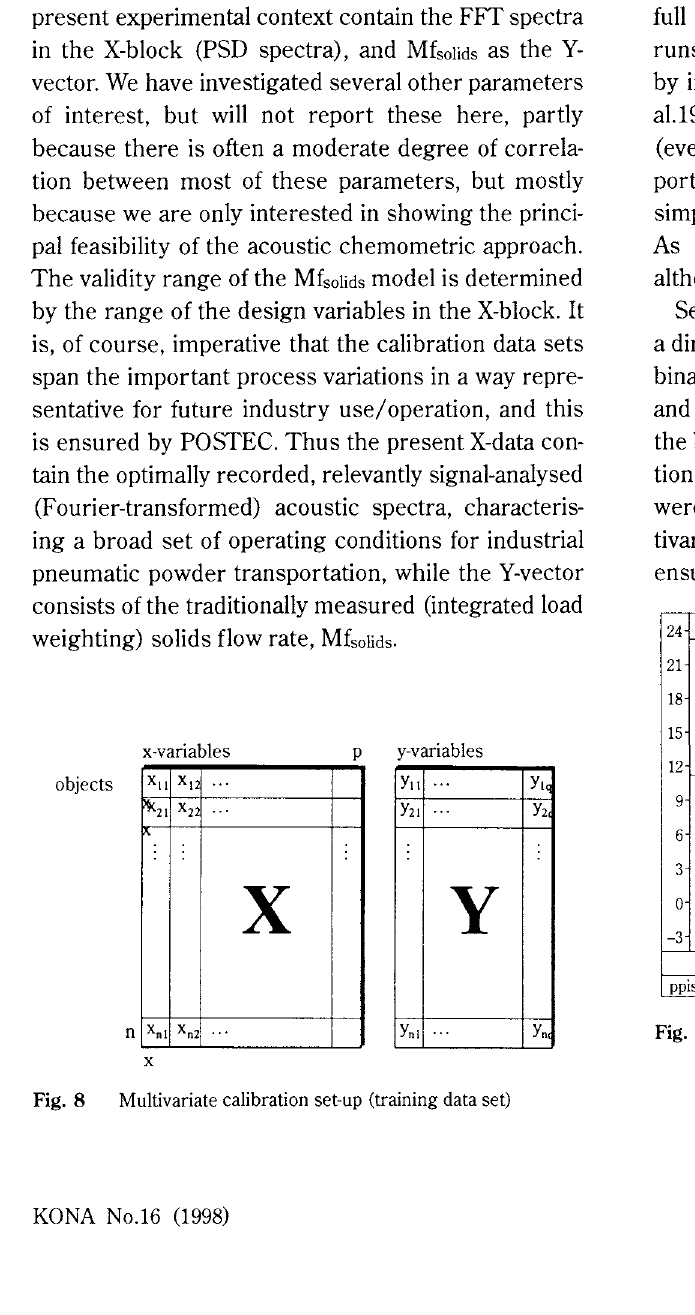
KONA No.16 (1998)